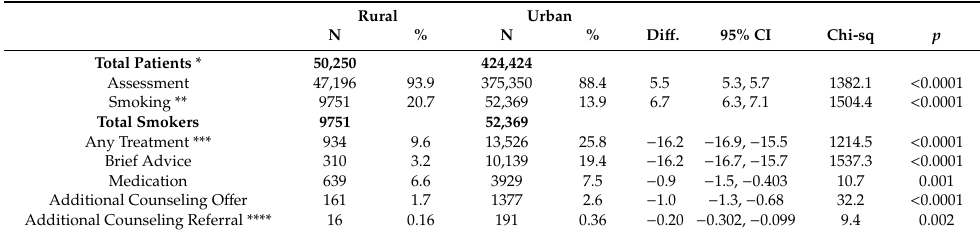
Table 2. Smoking prevalence and treatment among urban and rural clinics. Rural